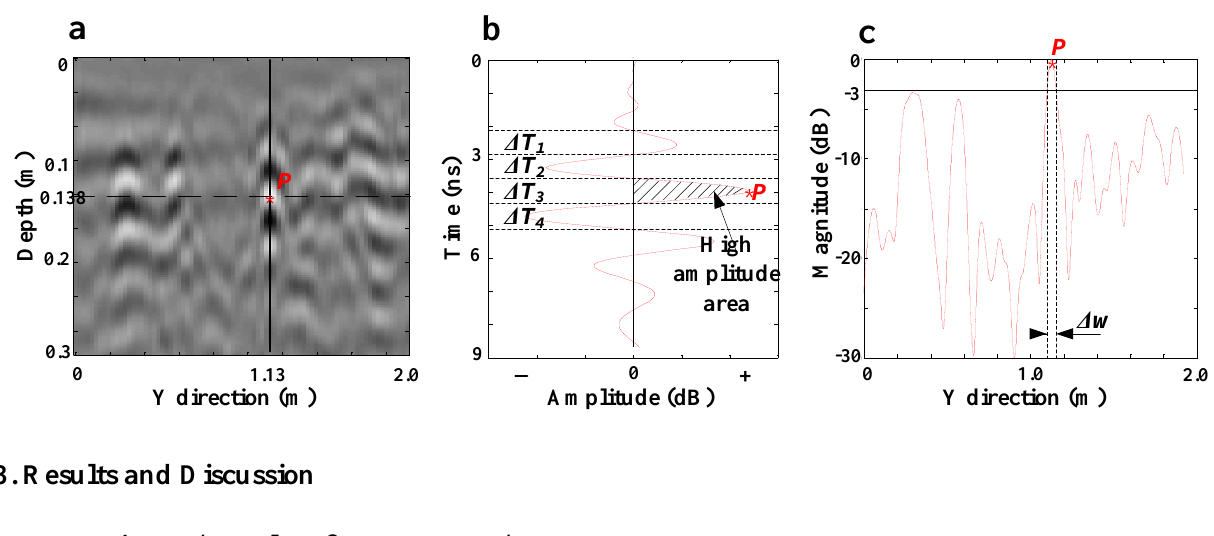
Figure 3. Schematic illustration of the extracted GPR indexes: ( a ) A migrated profile along a scanning line perpendicular with the root orientation. Point P locates at the peak position of the waveform right above the root. One vertical curve (indicated by solid line, at y = 1.13 m) and one horizontal curve (indicated by dashed line, at depth = 0.138 m) passing through peak P are extracted for subsequent analysis; ( b ) Definitions of high amplitude area and different time intervals between zero crossings are indicated based on the extracted vertical waveform; ( c ) Magnitude width ∆w of root is defined as the width (cm) between the −3 dB positions below the peak P in the extracted horizontal magnitude curve after Hilbert